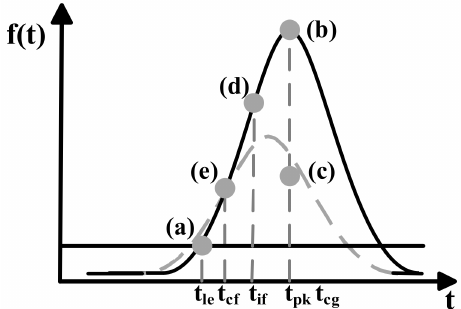
Figure 4. Time discrimination methods: ( a ) Leading edge, ( b ) peak, ( c ) center of gravity, ( d ) inflection, ( e ) constant